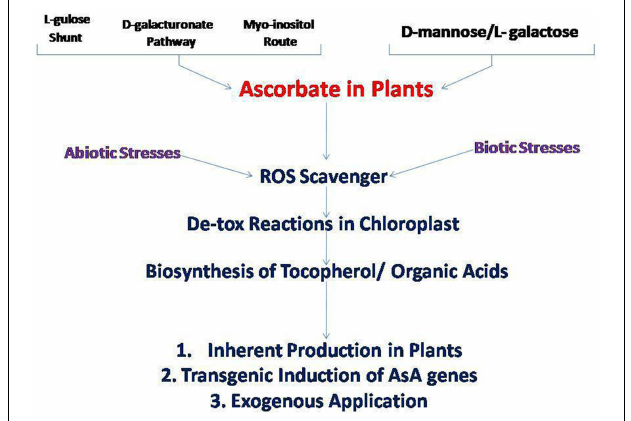
FIGURE 1 | Ascorbate metabolism in